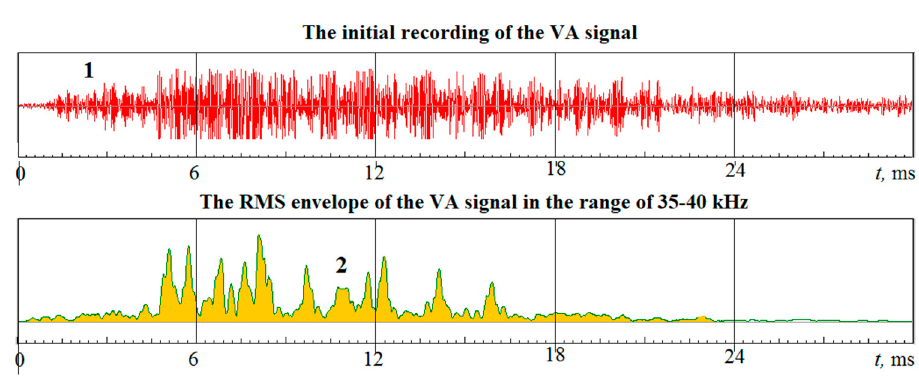
Figure 23. The initial recording of the VA signal ( 1 ); the RMS envelope of the VA signal in the range of 35–40 kHz in an averaging period of 0.14 ms ( 2 ).